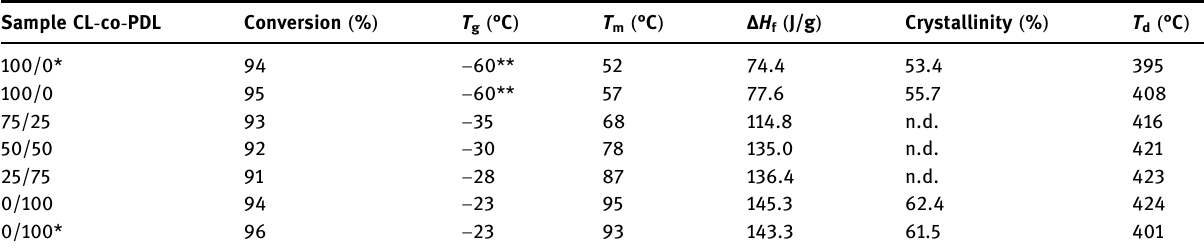
Table 2: Conversion and thermal properties of polyesters and copolyesters synthesized by microwave - assisted lipase - catalyzed ring - opening polymerization Sample CL - co -